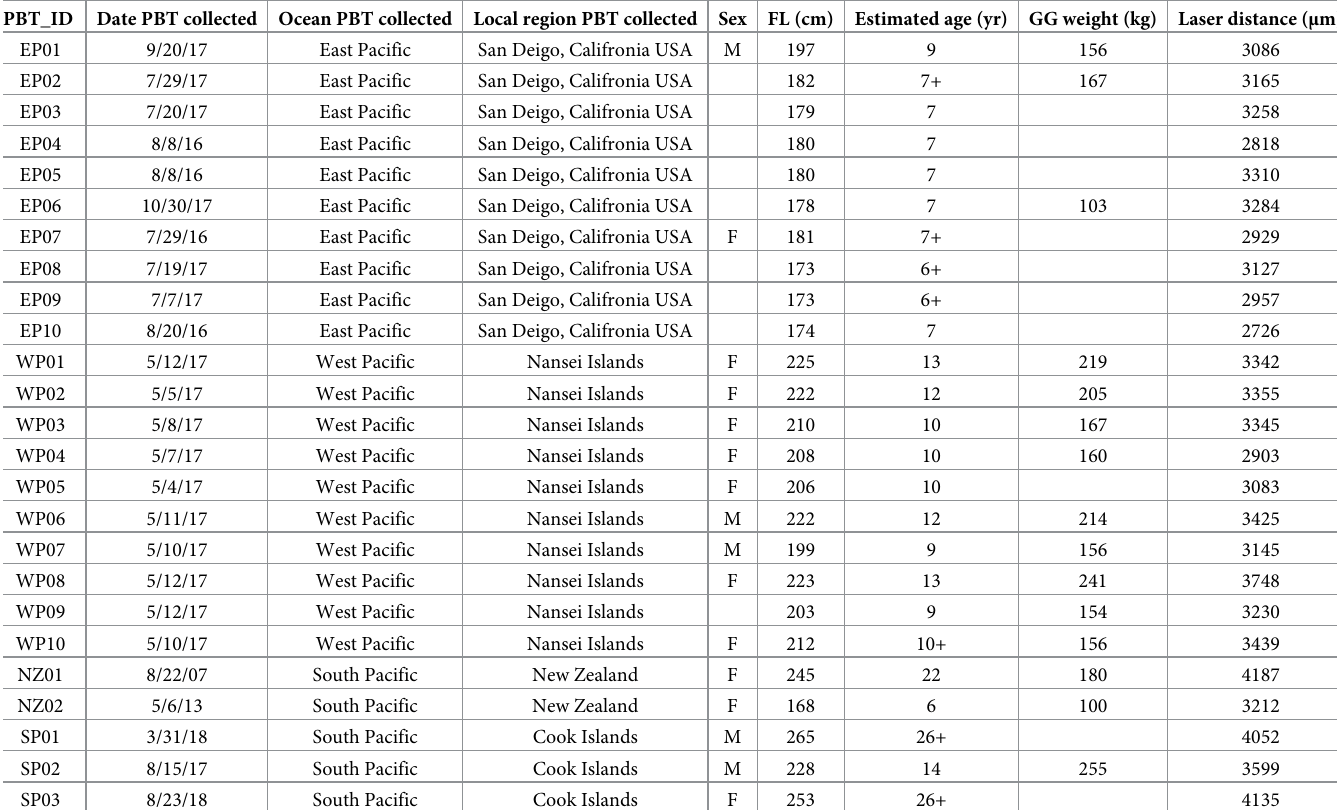
Table 1. Pacific bluefin tuna (PBT) metadata including date, ocean region of collection region, local region of collection; sex, gilled and gutted (GG) weight and fork length (FL) reported where available. Estimated ages were derived from length-age relationships reported in [32]. Laser distance measured as in Fig